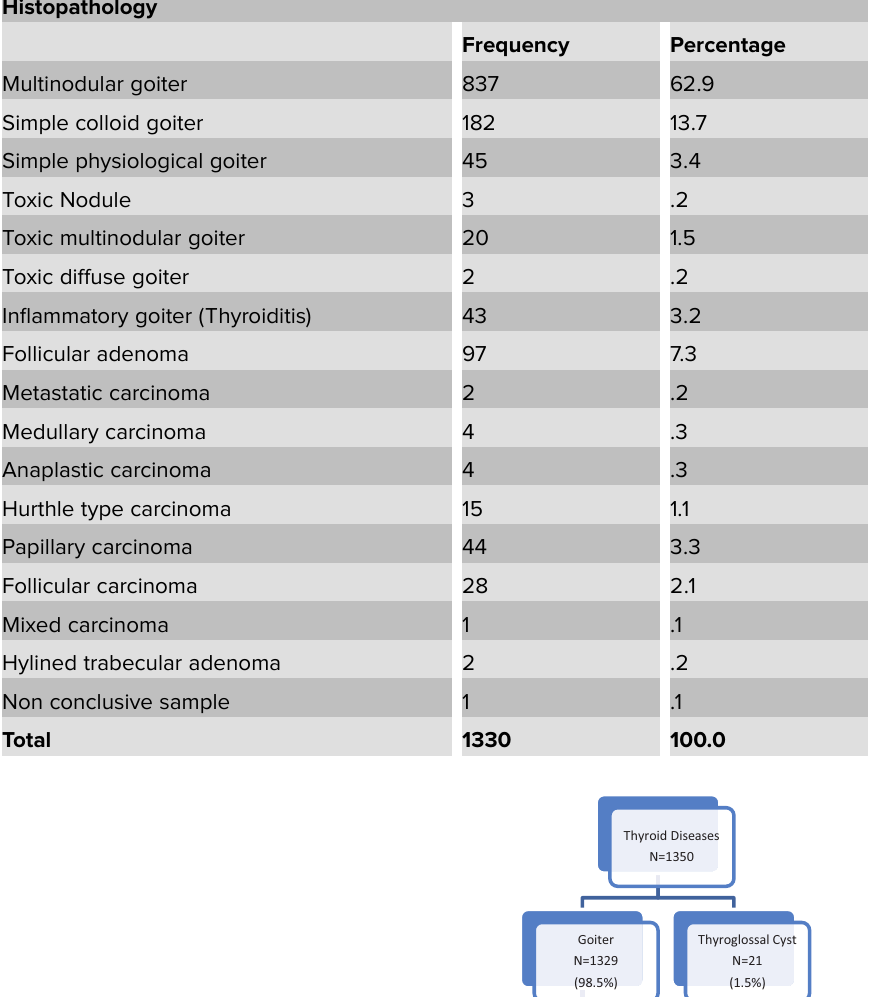
Table 1: Pattern of thyroid disease.